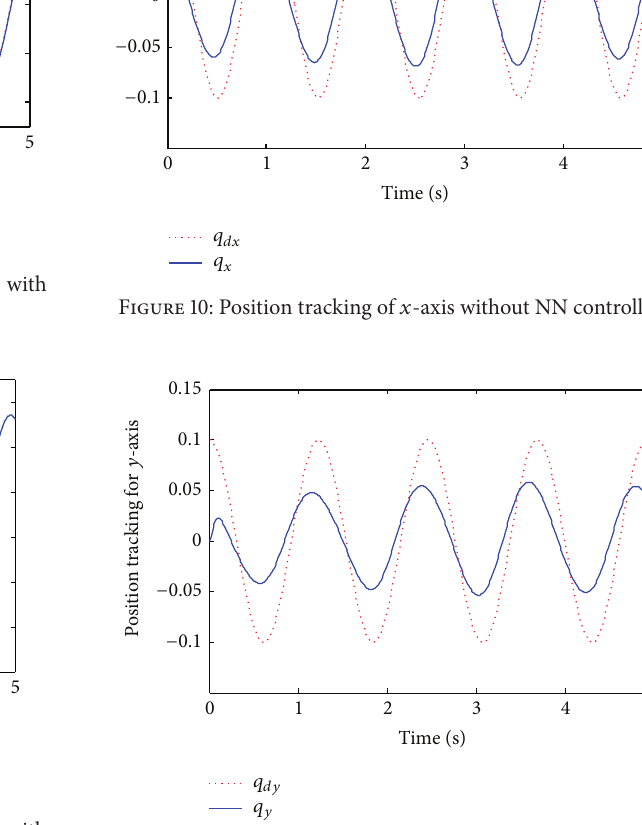
Figure 11: Position tracking of 𝑦 -axis without NN